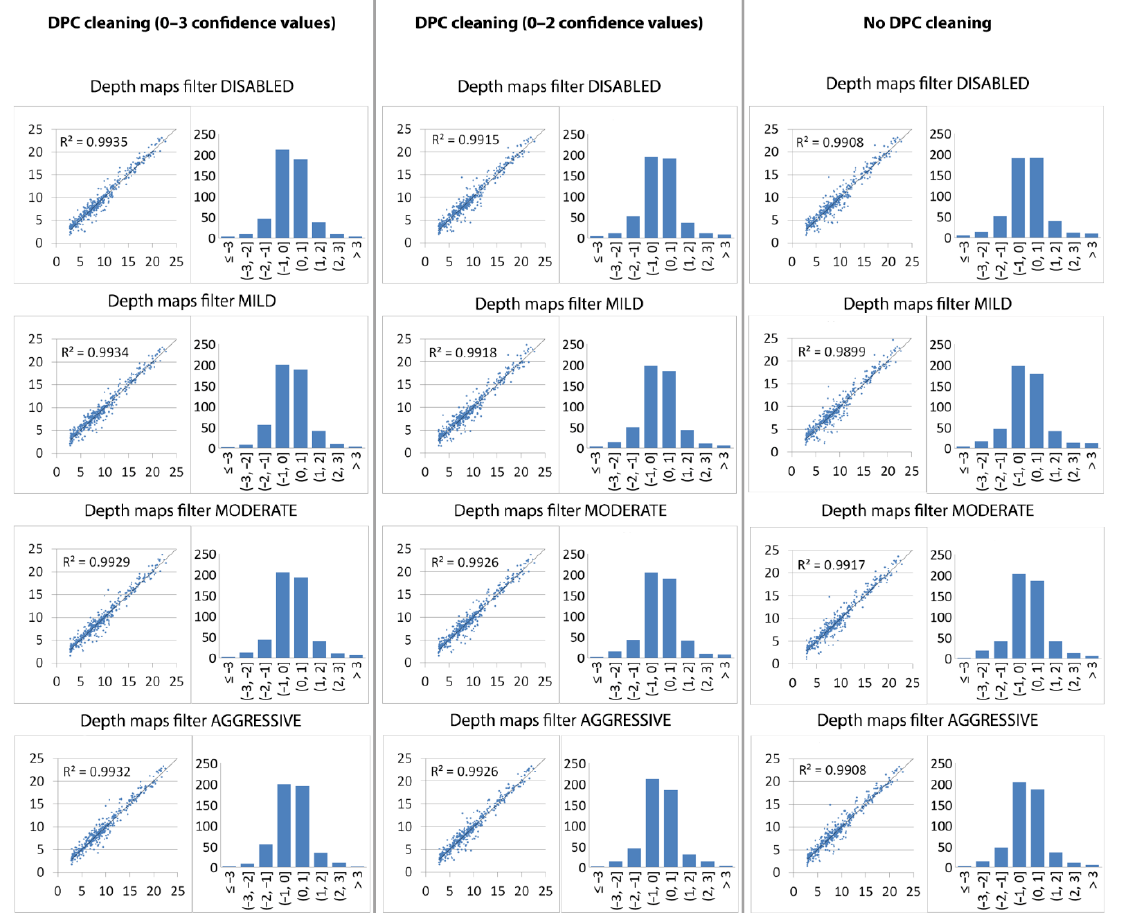
Figure 5. Comparison between each method used to build the dense point cloud (DPC) from 1963 aerial photographs. Scatter plots of elevations and frequency distributions of elevation residuals between 1963 digital surface models (DSMs) and 2014 light detection and ranging (LiDAR) datasets are compared. Values in the X-axes of scatter plots are LiDAR elevations, while Y-axis values are DSM elevations; all values are given in meters. Values in the X-axes of frequency distributions are elevation residuals given in meters, while values in the Y-axes are number of check points (n = 512).